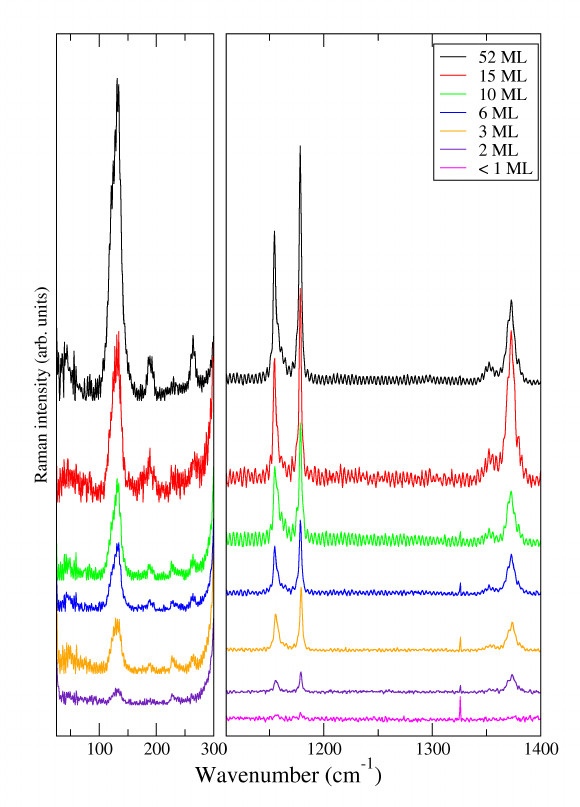
Figure 3. Raman spectra of pentacene films as a function of thickness (in ML). Only the spectral regions of interest are reported.